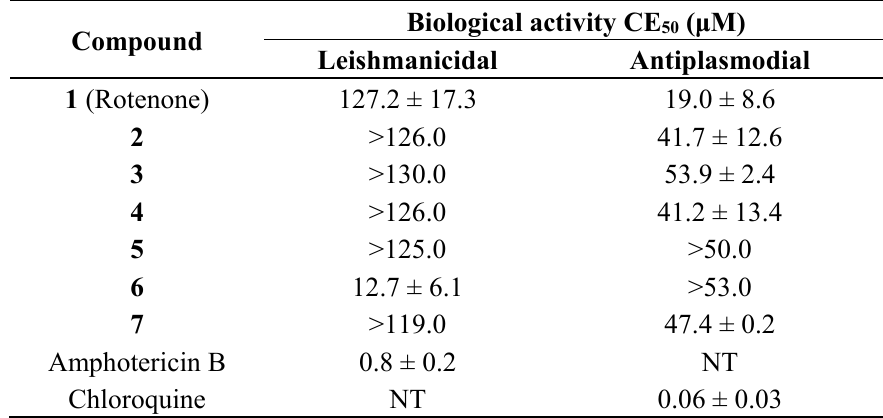
Table 2. In vitro antiparasite activity of rotenone and its derivatives.